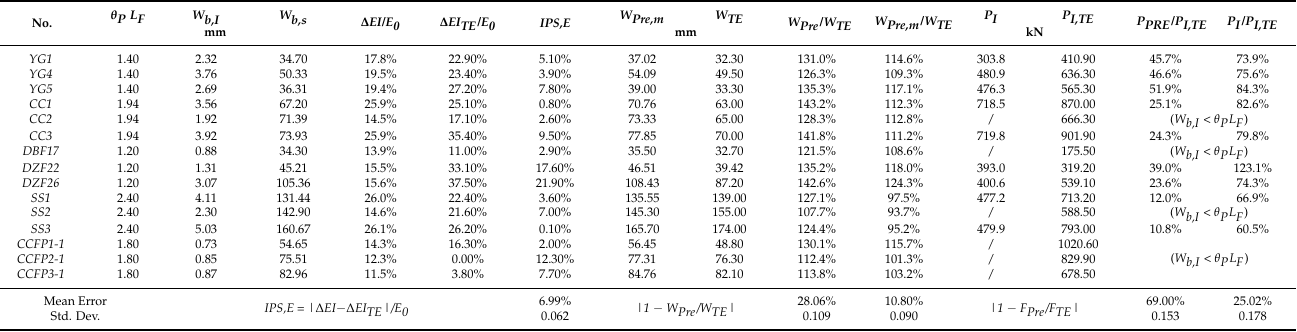
Table 3. Design results of the two-step